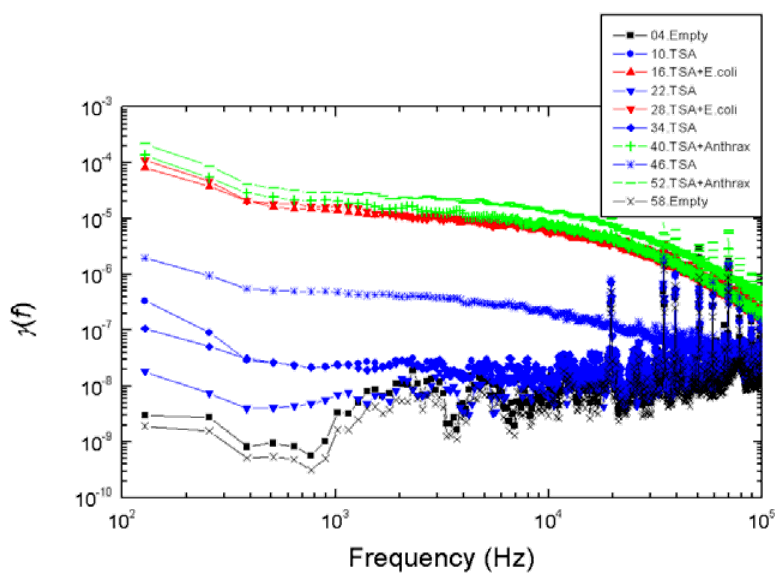
Figure 7. Reproducibility of the experimental data shown in Figures 5-6 with new samples.